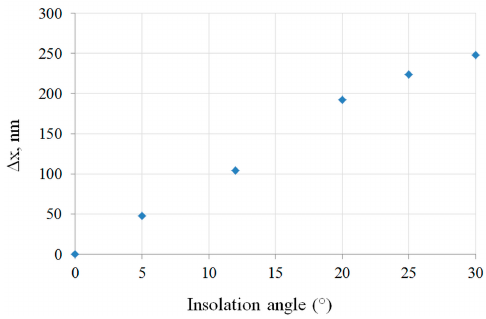
Figure 2. Lateral shift of the maximum intensity of the nanojet inside the TiO 2 film versus exposure angle.